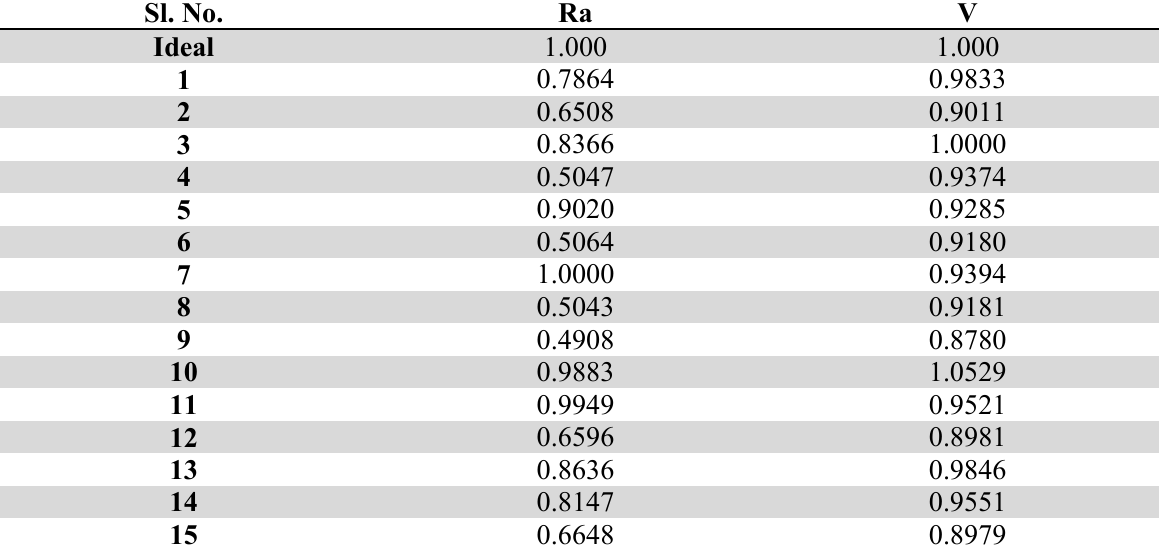
Normalized responses for surface roughness and vibrations Sl. No.